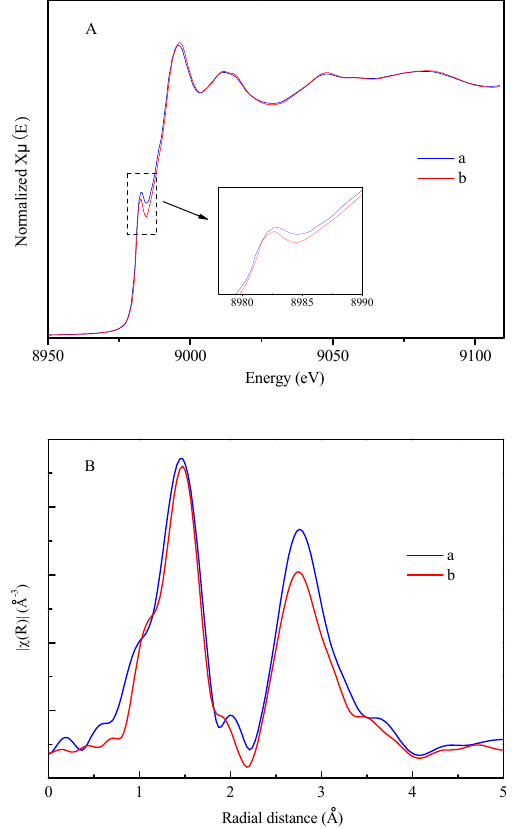
Figure 6. Cu K-edge data of Cu 2 O samples. ( A ) X-ray absorption near-edge spectroscopy (XANES) and Figure 6. Cu K ‐ edge data of Cu 2 O samples. ( A ) X ‐ ray absorption near ‐ edge spectroscopy (XANES) ( B )extendedX-rayabsorptionfinestructure(EXAFS)Fouriertransforms. ( a )Cu 2 O-NO 3 ; ( b )Cu 2 and ( B ) extended X ‐ ray absorption fine structure (EXAFS) Fourier transforms. ( a ) Cu 2 O ‐ NO 3 ; ( b ) Cu 2 O ‐ Cl(2).